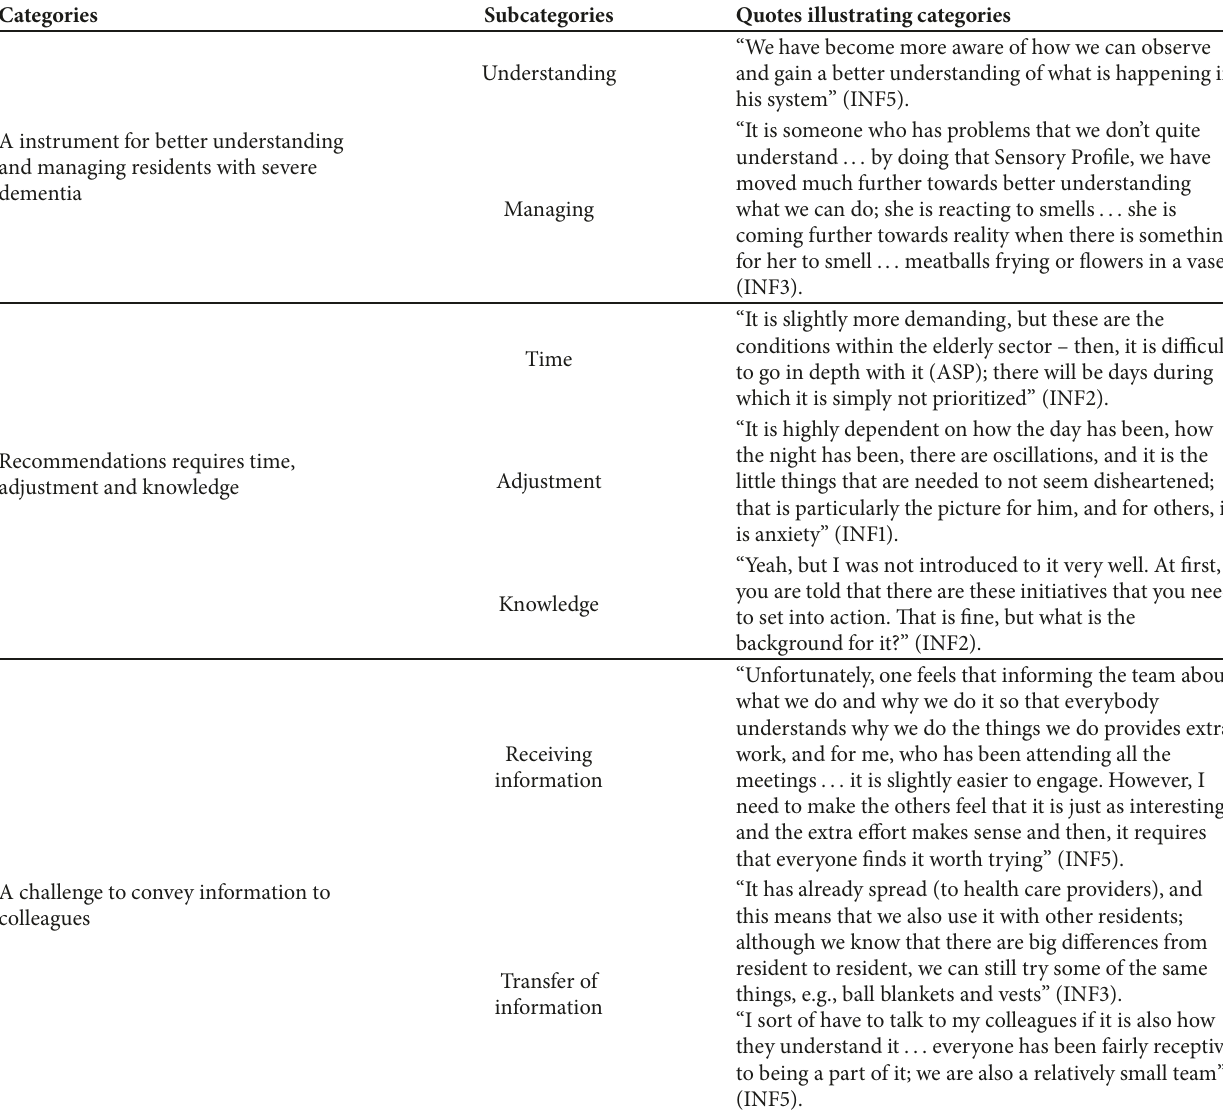
Table 1: Identified categories, corresponding subcategories, and